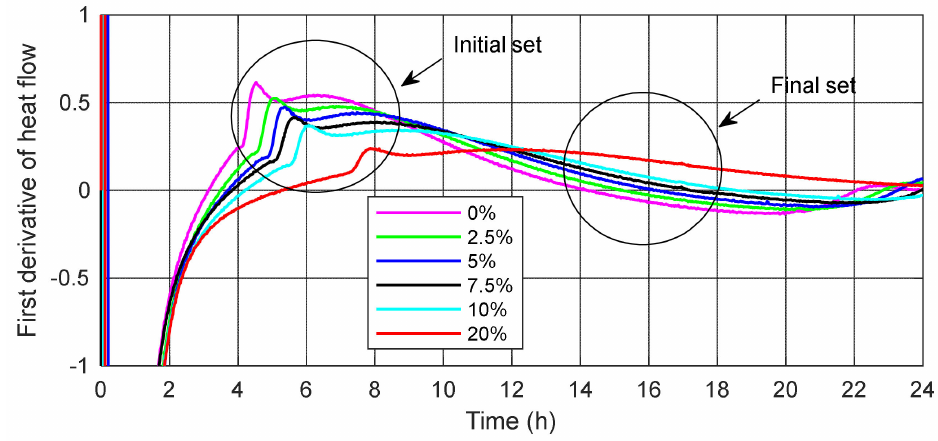
Figure 6. Initial and final setting time for the cement mortars without and with 2.5%, 5%, 7.5%, 10% and 20% sewage sludge ash SSA. Table 7. The determination of calorimetry set times for cement mortars with SSA. Setting Time